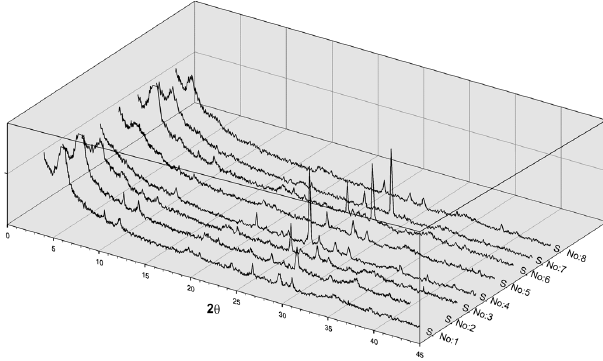
Fig. 13. XRD results of selected samples.